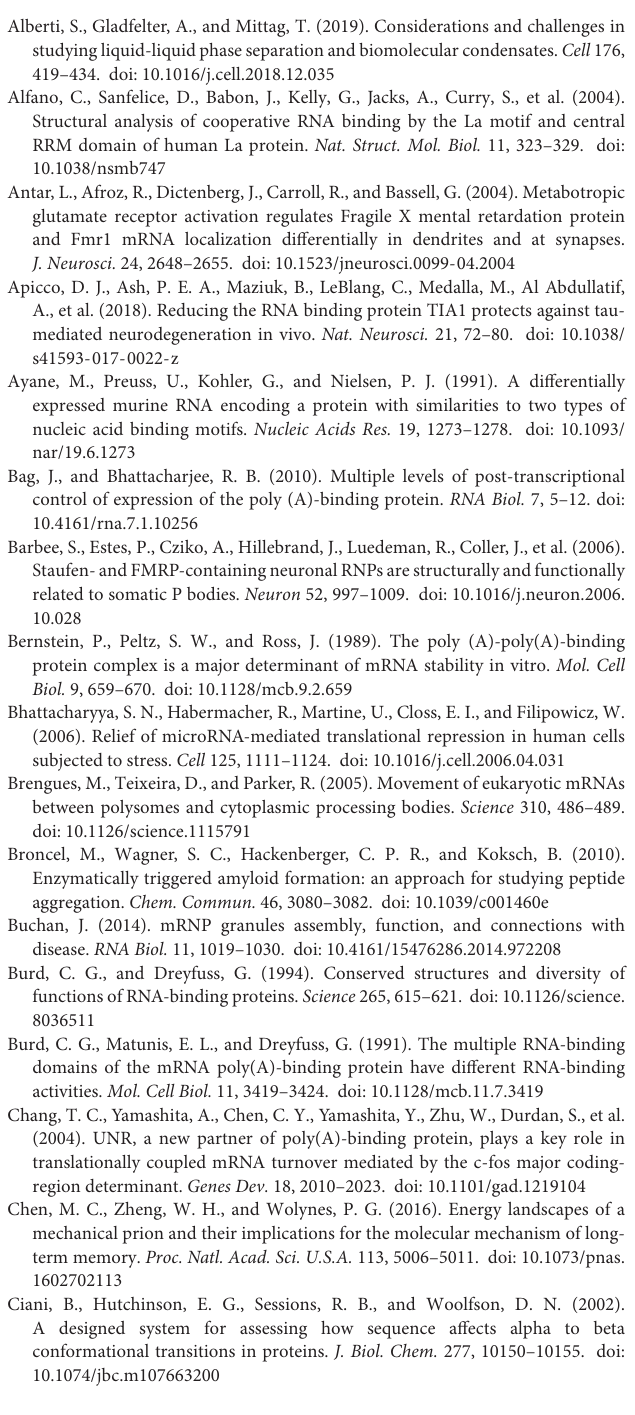
type of RNA binding domain. The software Coils was used to predict the presence of CC in RBP listed in the database RBPDB; (B) Graphical representation of coiled coil prediction for members of each family. Below each graph a schematic of the organization of the RNA binding domains (RBD, black) and CC motifs (blue) is shown. RBD and CC are justaxposed, with minimal or no overlap.